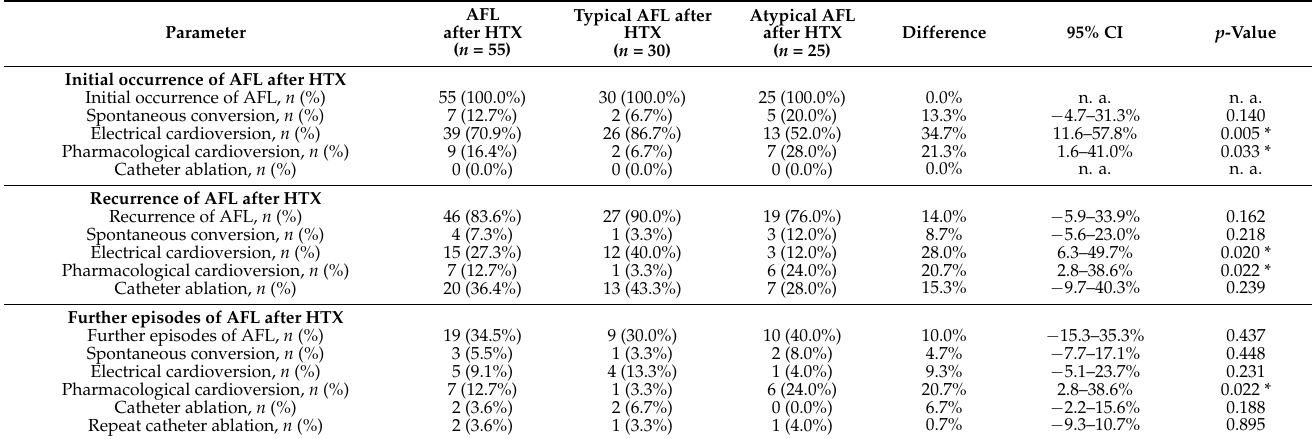
Figure 1. One-year freedom from further episodes of post-transplant AFL stratified by patients with and without catheter ablation after recurrence of late-onset post-transplant AFL (Kaplan–Meier estimator). Patients with catheter ablation after recurrence of late-onset post-transplant AFL had a significantly lower 1-year rate of further episodes of post-transplant AFL than patients without catheter ablation ( p = 0.003). AFL = atrial flutter; * = statistically significant ( p < 0.050). Table 7. Treatment of patients with late-onset AFL after HTX.